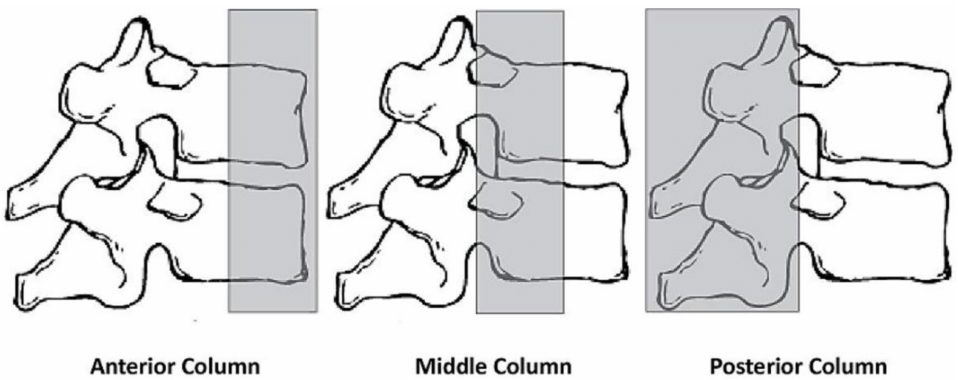
Figure 2. Schematic representation of Denis’ three column